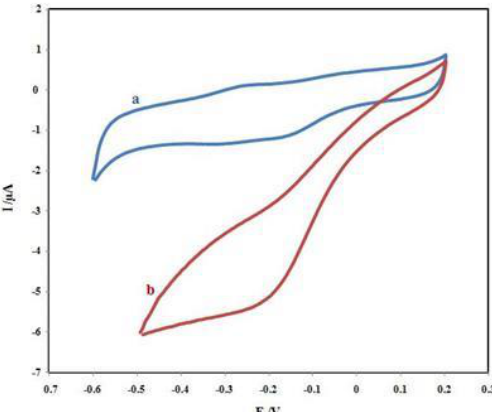
Fig. 4. CVs of Cyt c on a nafion-rGO/GC electrode in the absence (a) and in the presence of a 1.0 mM H 2 O 2 (b).